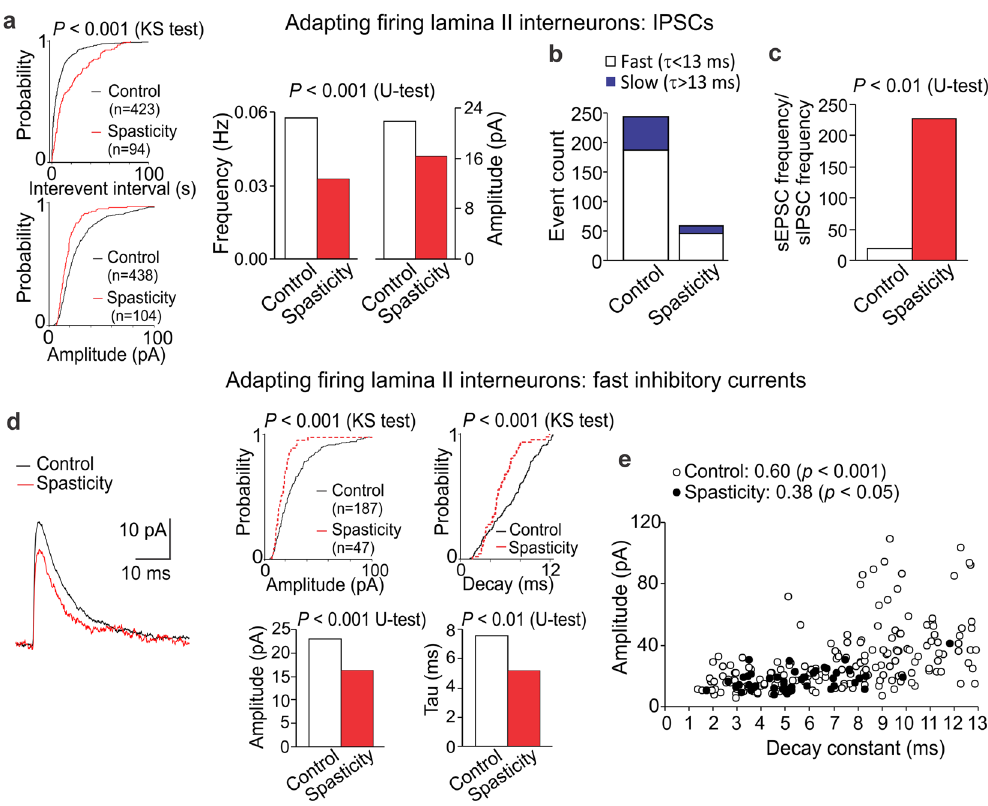
Figure 6. The SCI-induced loss of inhibition in AFNs. ( a ) Cumulative probability plots for the inter-event interval and the amplitude of sIPSCs (left) and summary of the median frequency and the median current amplitude (right) in AFNs in control and spasticity. ( b ) Occurrence of the fast ( τ < 13 ms) and the slow ( τ > 13 ms) inhibitory currents in different experimental conditions. ( c ) The average balance between synaptic excitation and inhibition of AFNs, estimated as the median frequency of sEPSCs to the median frequency of sIPSCs for each individual AFN in control (n = 14 cells) and spasticity (n = 10 cells). ( d ) Left, examples of the fast inhibitory currents in control (black line, average of 112 fast currents recorded in 15 AFNs) and in spasticity (red line, average of 25 fast currents recorded in 10 AFNs). Right, cumulative probability plots (upper raw) and summary of the median current amplitude and the decay time constant (lower raw) in AFNs in control and spasticity. ( e ) The amplitude of fast IPSCs ( τ < 13 ms) plotted against its current decay constant in AFNs in control and spasticity. The Spearman correlation coefficients and the Spearman’s non-parametric test significance are indicated. The Kolmogorov- Smirnov (KS) or the Mann-Whitney U-test significance is